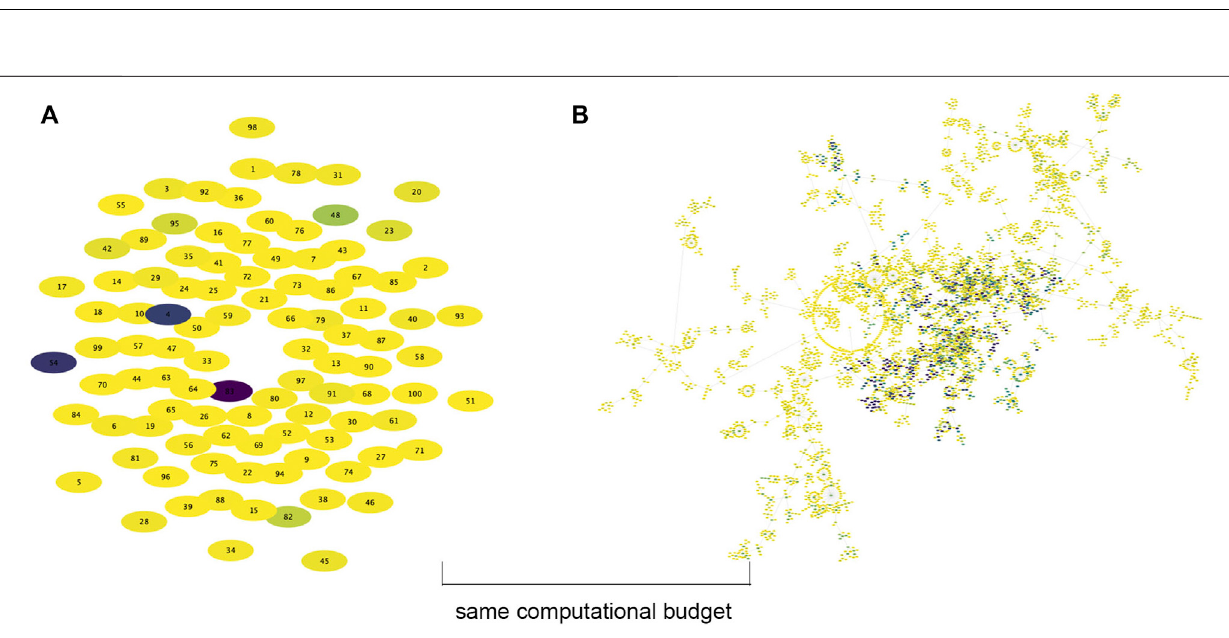
FIGURE 8 | The genealogical trees of a single evolutionary run of both methods with the same computational budget: 30,000 evaluations. Each elliptical node represents a single robot. The node color indicates fi tness (the darker the color the higher the fi tness). The highest fi tness found by Evolution + Learning is 31.90 (robot 83), whereas the highest fi tness found by Evolution-Only is 1.92 at the end of 199 generations. (A) Evolution + Learning (generation 1). (B) Evolution Only (generation 199).